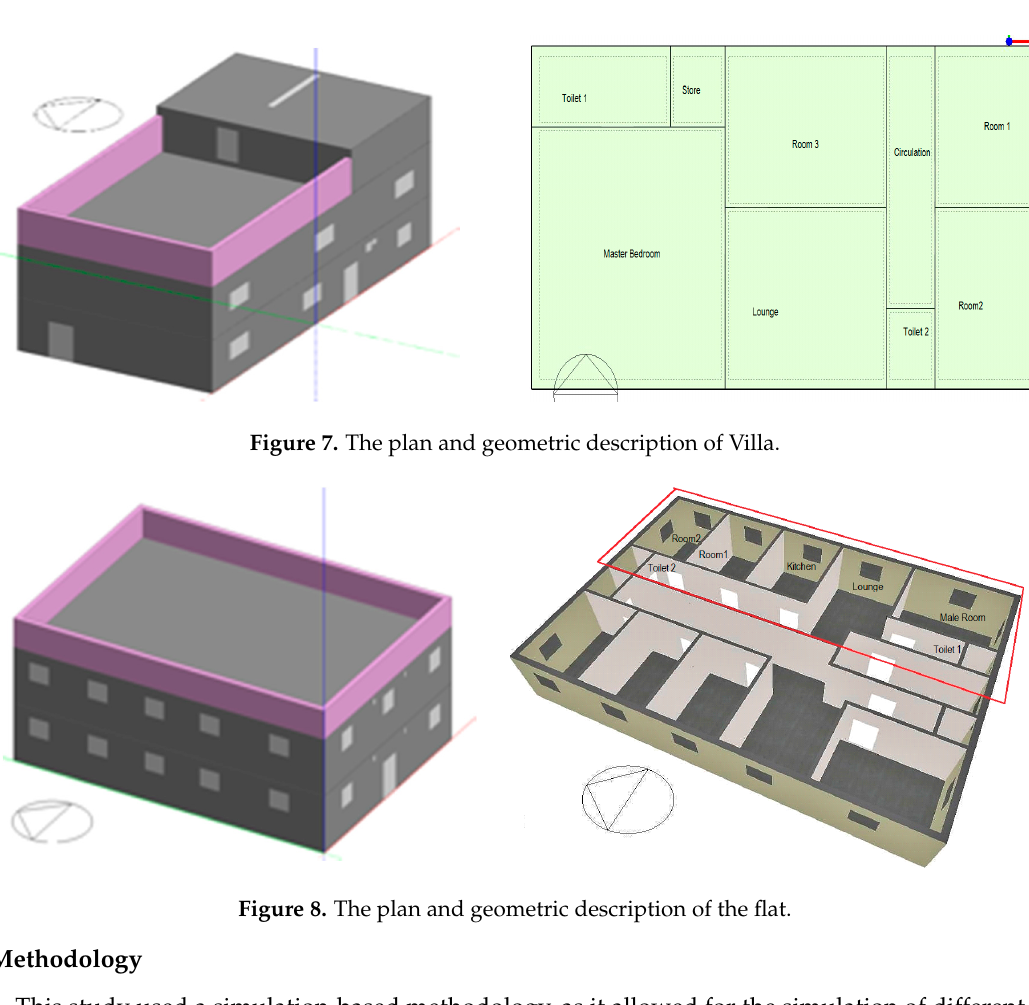
Figure 6. The plan and geometric description of House 2.